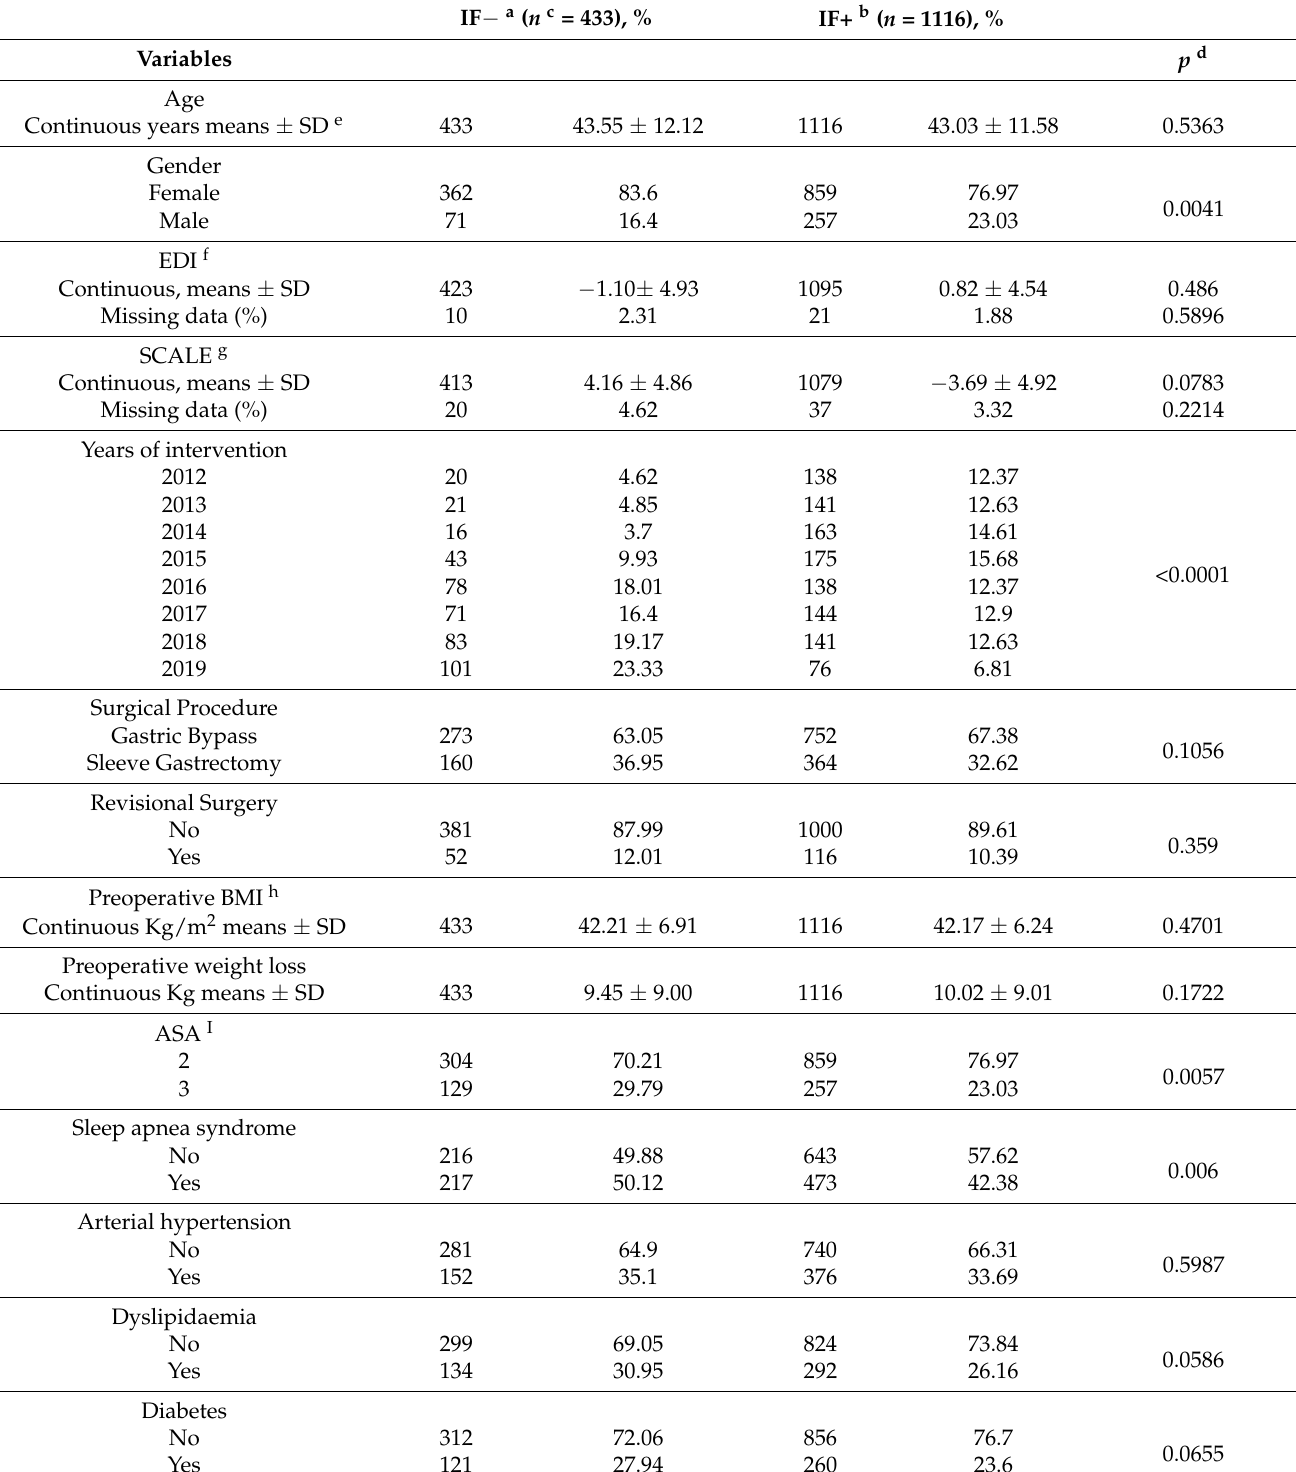
Table A1. Characteristics of patients included in the Cox